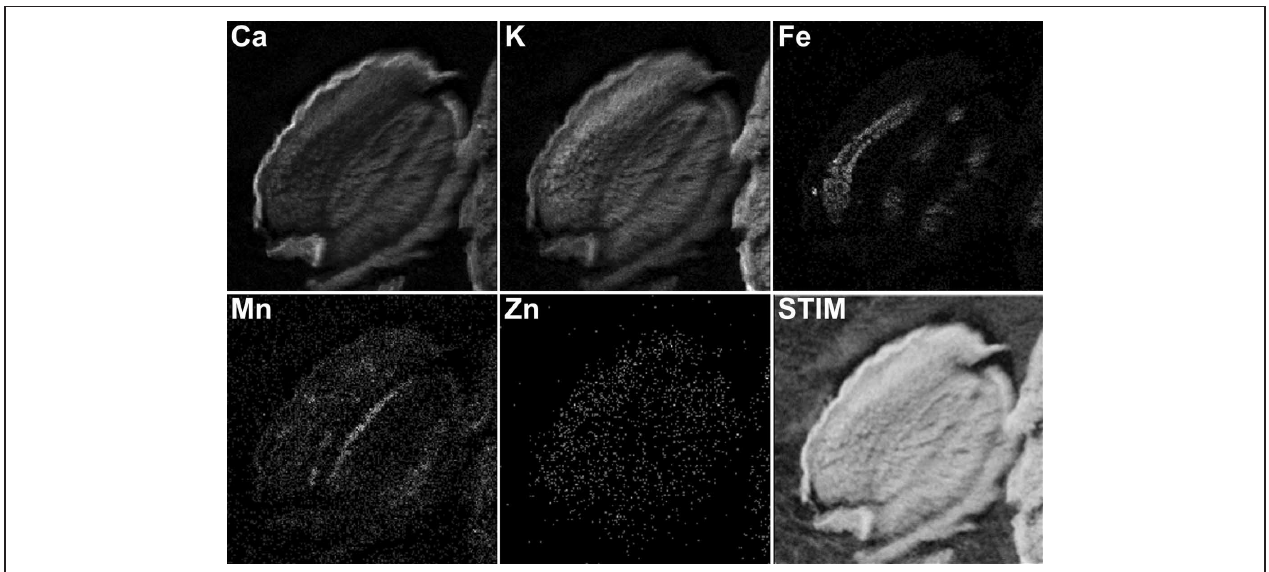
FIGURE A1 | µ PIXE elemental reconstituted image of Arabidopsis thaliana dry seed section. Total X-ray spectra of areas scanned with 3 MeV proton beam were collected. Specific distributions of Ca, K, Fe, Mn,